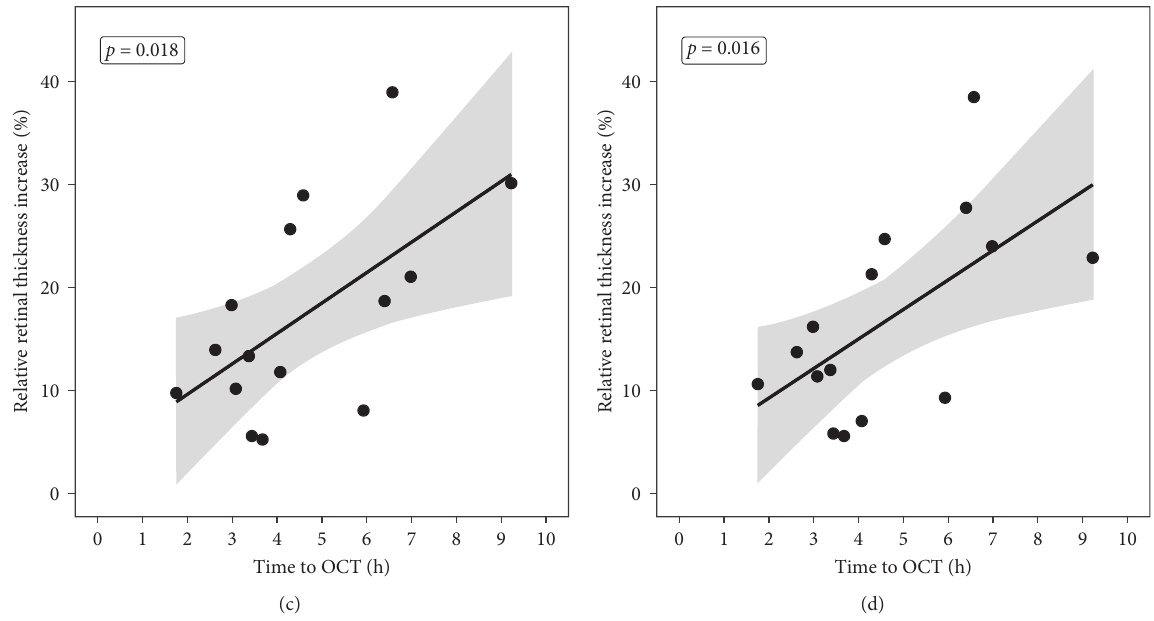
Figure 2: Time-dependent increase of the relative retinal thickness over 10 hours. The figure displays the RRTI in all ETDRS sectors: (a) inferior, (b) superior, (c) nasal, and (d) temporal ( n � 15). In every figure, the x -axis represents time to OCT (TTO) and the y -axis the RRTI in percent in the respective sectors. Every dot represents an analyzed patient. The straight line is the ordinary least squares (OLS) regression over the first 10 hours after ischemia onset. The grey region around the regression line describes the 95% confidence interval for the expected value of y given x . It reflects the confidence in estimated (ROC) curve analysis was used to display true positive and false positive rate.